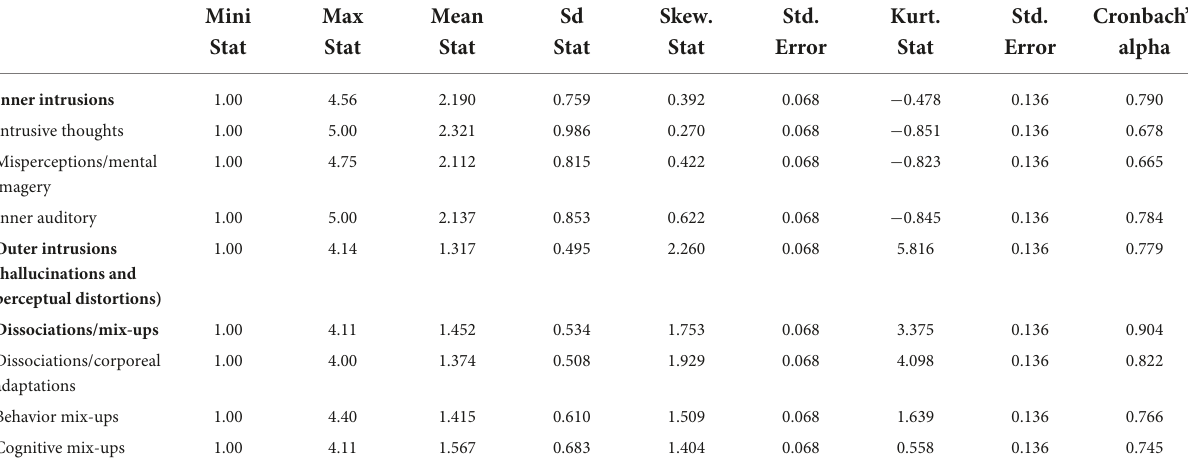
TABLE 6 Descriptive statics for each of the GTP